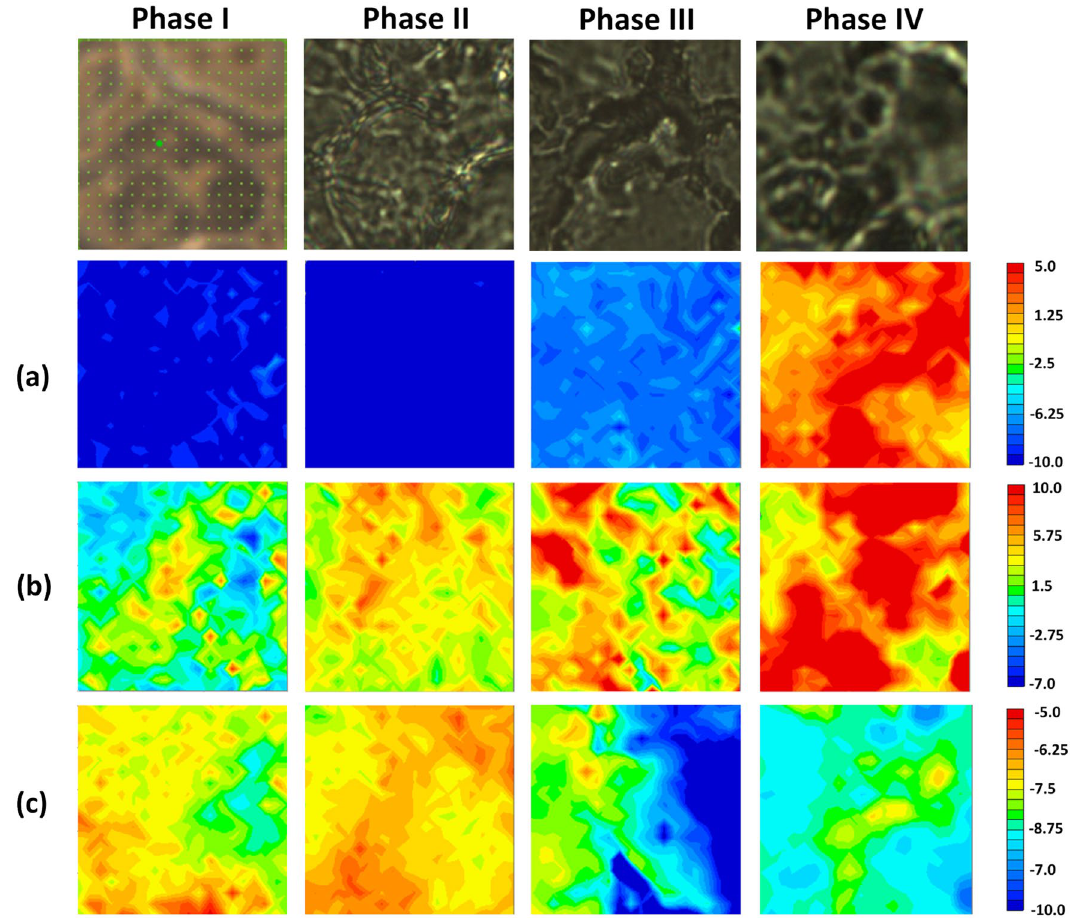
Figure 4. Visible images of cells at each Phase and Raman imaging with a 20 μm × 20 μm area for fixed cells for the four phases obtained by plotting ( a ) the band intensity at 673 cm −1 for the C-S-C stretching